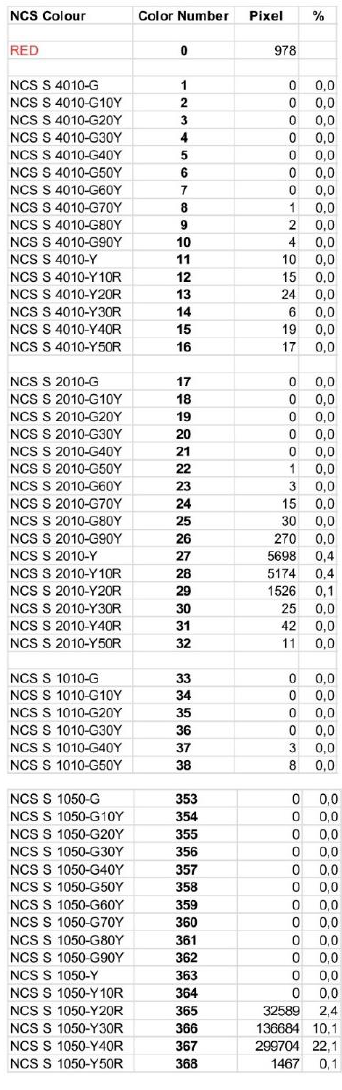
Figure 9. Mango color results as provided by the software WinFoodEval. Color codes according to NCS classification. All codes are given with full abbreviations, pixel values, and distribution. (This is a zoom from Figure 6).